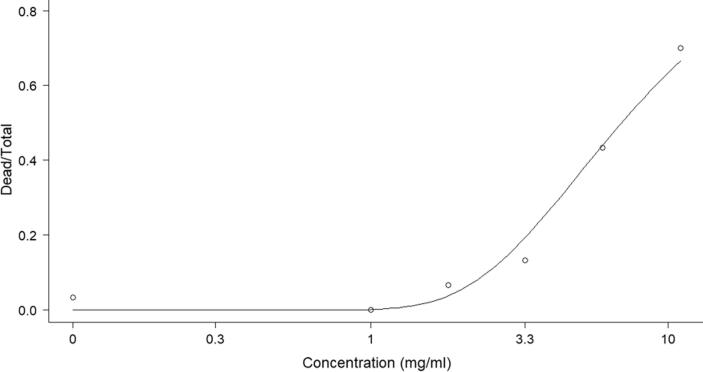
Proportion mortality of G. mellonella larvae following cordycepin treatment. Mean proportional mortality of G. mellonella larvae (N = 30 for each dose) injected with 1, 1.82, 3, 6 and 11 mg ml−1 of cordycepin and a DMSO control on day 6 after treatment. A type 1 Weibull model is fitted to the response.